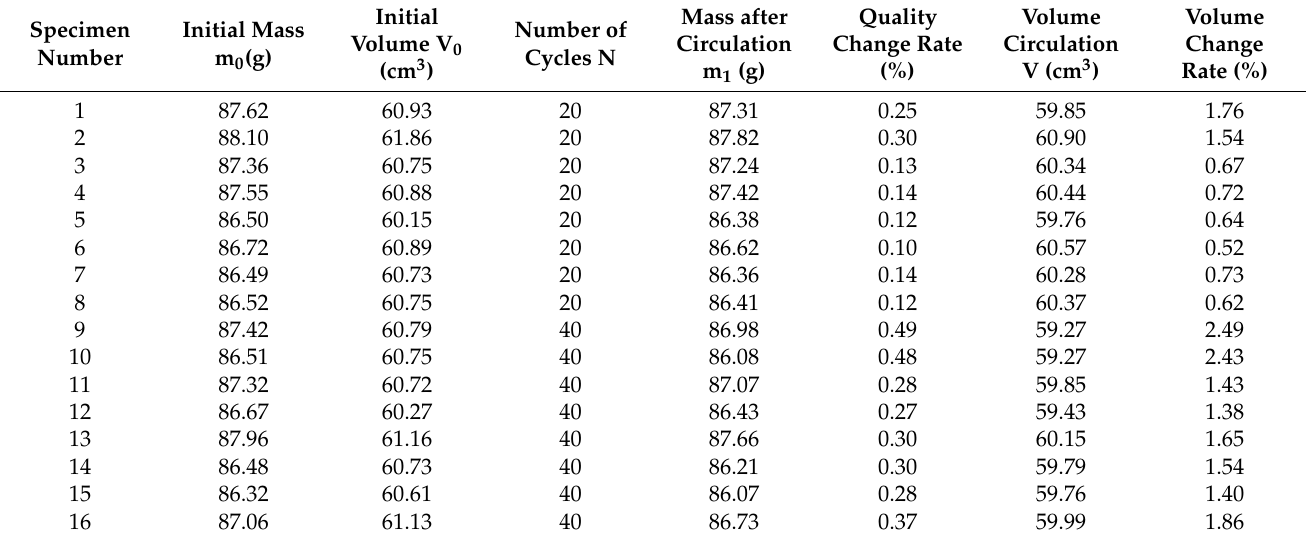
Table 8. Dry and wet cycle test.